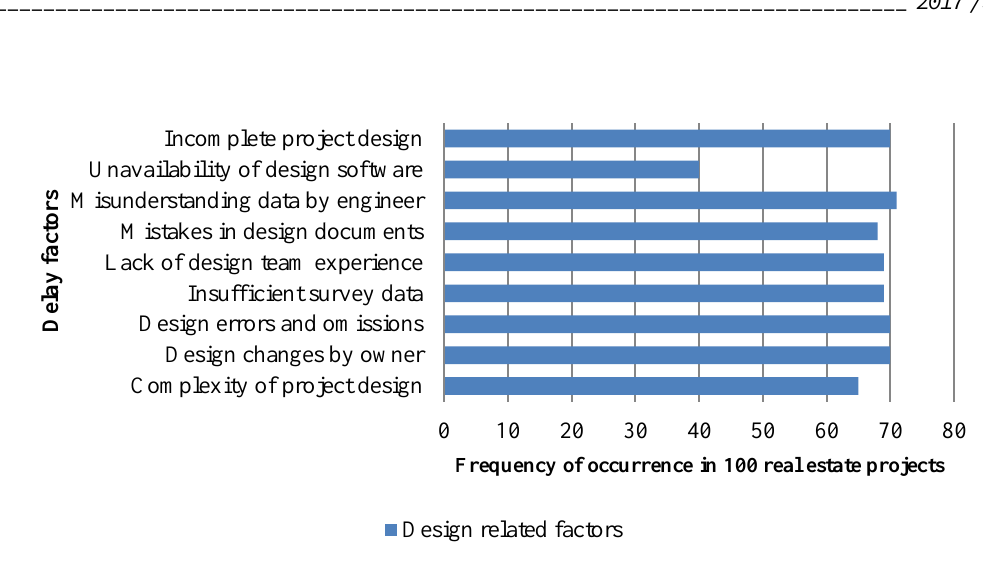
Fig. 5. Frequency of design-related delay factors [figure made by authors].